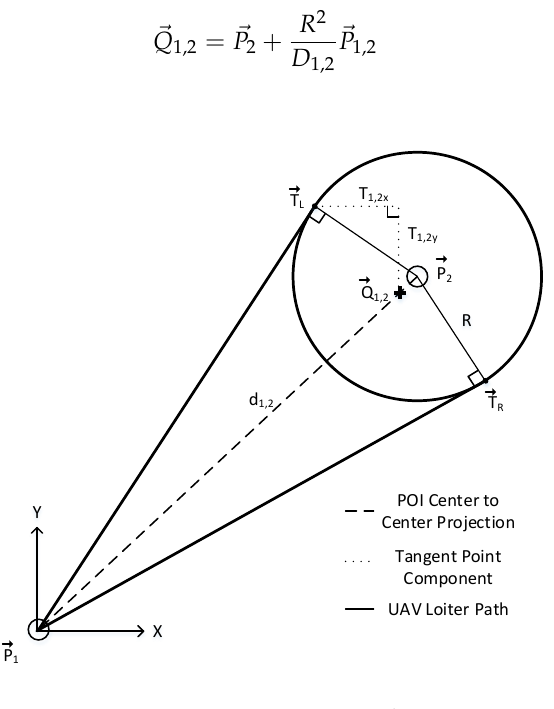
Figure 7. Tangent point